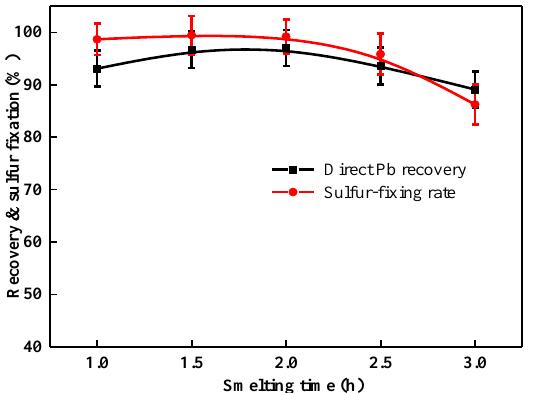
Figure 8. The effects of treatment time on lead recovery and sulfur fixation. (W lead paste :W Na2CO3 :W pyrite cinder :Wcoke = 200:8:50:24 g, FeO/SiO 2 = 1.3, CaO/SiO 2 = 0.4, 1200 °C).